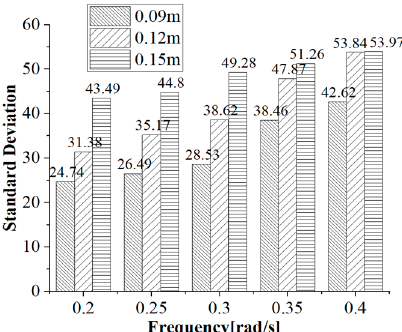
Figure 24. Standard deviation of heave response at different frequencies.